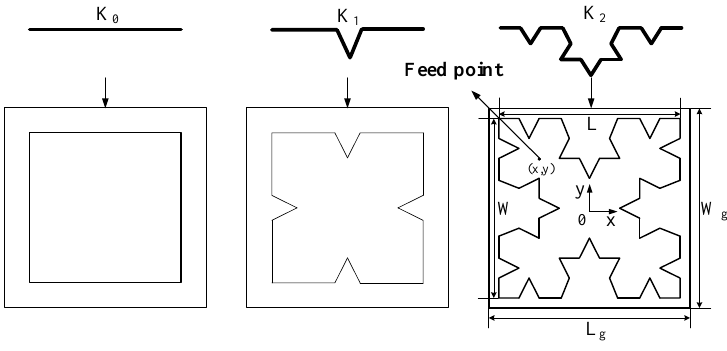
Figure 1. Koch fractal patch antennas with fractal dimensions of 0, 1 and